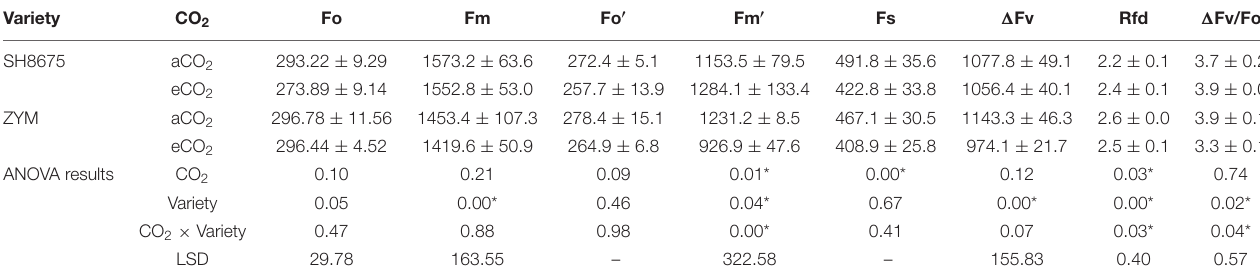
TABLE 3 | Effects of elevated CO 2 on chlorophyll fluorescence emission and attenuation of two winter wheat varieties. Variety CO 2 Fo Fm Fo (cid:48) Fm (cid:48) Fs (cid:49) Fv Rfd (cid:49) Fv/Fo